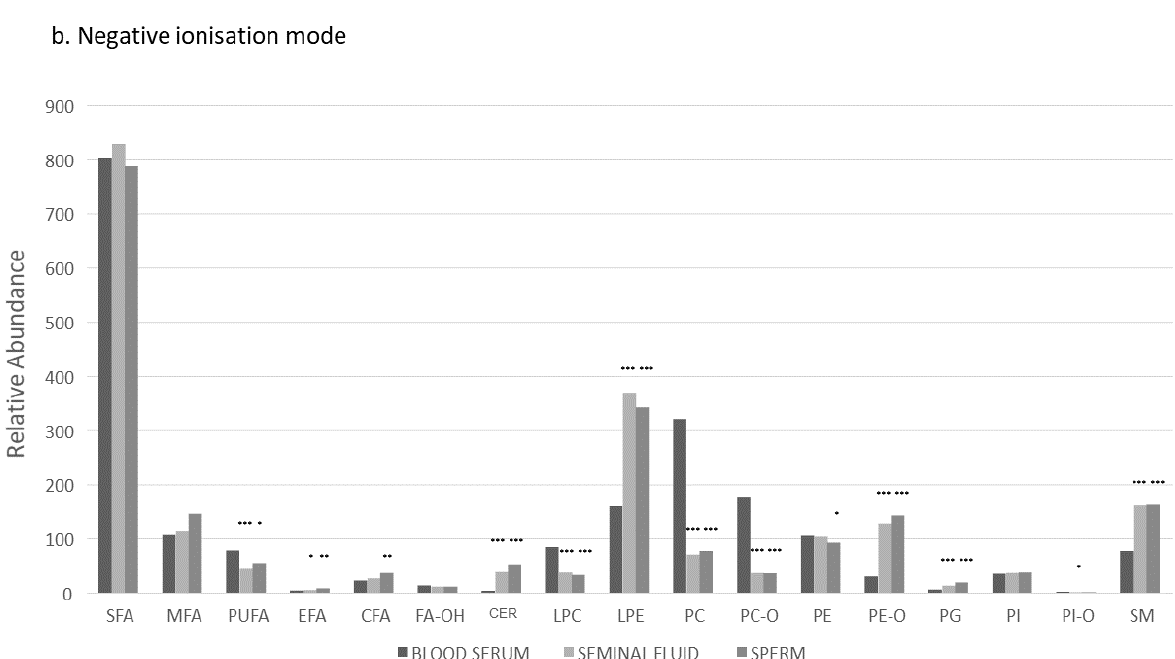
Figure 1. Distribution of lipid classes as measured using direct infusion mass spectrometry. Each sample was analysed with the mass spectrometer in positive ionisation mode for the measurement of protonated and ammoniated lipid adducts ( a ), negative ionisation mode for deprotonated ions and additionally with high collision energy to measure fatty acids ( b ). Lipid classes were as follows: ceramides (CERs), cholesterol (CHOL), essential fatty acids (EFAs), lyso -phosphatidylcholines (LPCs), lyso -phosphatidylethanolamines (LPEs), mono-saturated fatty acids (MFA), phosphatidylcholines (PCs), phosphatidylcholine-plasmalogens (PC-Os), phosphatidylethanolamines (PEs), phosphatidylethanolamine-plasmalogens (PE-Os), phosphatidylglycerides (PGs), phosphatidylinositols (PIs), phosphatidylserines (PSs), polyunsaturated fatty acids (PUFAs), saturated fatty acids (SFA), sphingomyelins (SMs), and triglycerides (TGs). Significance testing shows comparisons with blood serum only; * p ≤ 0.05; ** p ≤ 0.01, *** p ≤ 0.001. Note the limit of significance was p < 0.001. Values were not adjusted for lipid class ionisation efficiency.